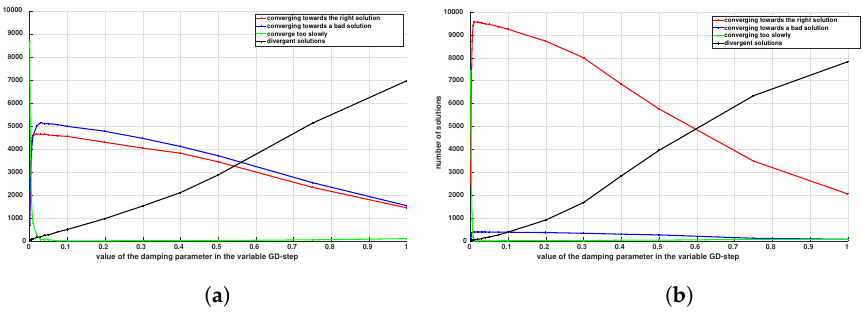
Figure 7. Analysis of convergence results over 10,000 simulations using the adaptive gradient descent for estimation problem (5) including position and measurement error models, based on the measurements from 4 and 10 neighboring nodes, respectively. The red curves show the number of correct estimates, the blue curves correspond to the number of estimates corresponding to local minima, and the green and black curves correspond to non-convergence of the estimation due to reaching the maximum number of iterations (very slow convergence) or to the divergence of the estimation algorithm, respectively. Note that β = 1 corresponds to the classic formulation of variable- step gradient descent. ( a ) Based on 4 relative measurements; ( b ) Based on 10 relative measurements. Table 2. Comparative localization results using the different formulations of the estimation problem, based on 4 relative measurements, with and without taking into account uncertainty models.